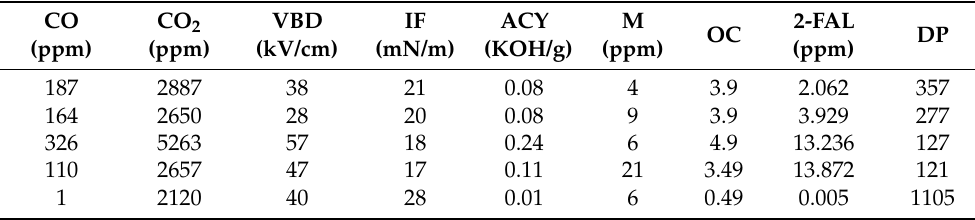
Table 3. Some of the dataset samples in the current study. CO: carbon monoxide; CO 2 : carbon dioxide; VBD: breakdown voltage; IF: interfacial tension; ACY: acidity; M: moisture; OC: oil color;